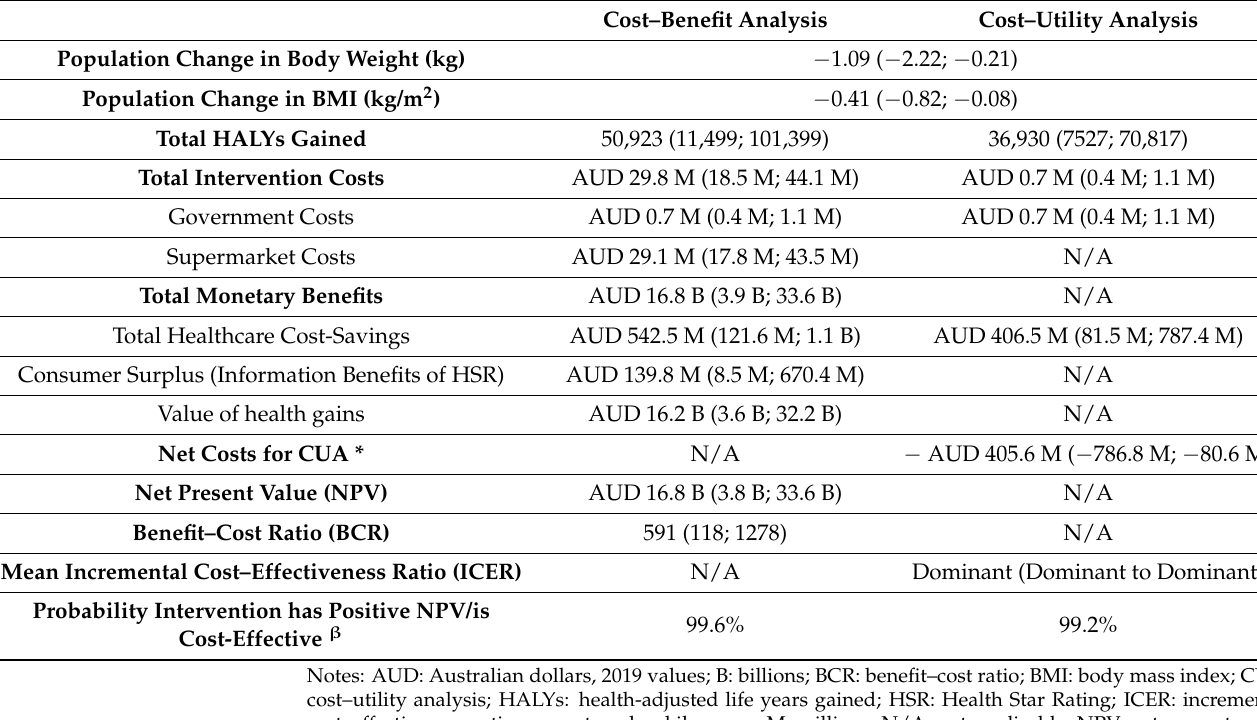
Table 3. Cost-effectiveness results, mean (95% UI).